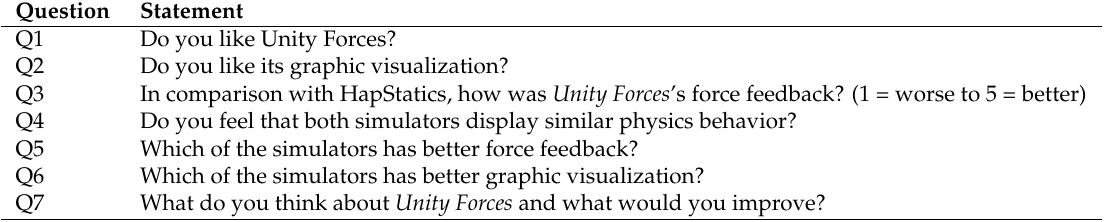
Figure 19. ( a ) User grabbing the first virtual block and experiencing its weight, and ( b ) User releases the first virtual block and it experiences freefall. Table 1. Perception questionnaire applied to participants after testing Unity